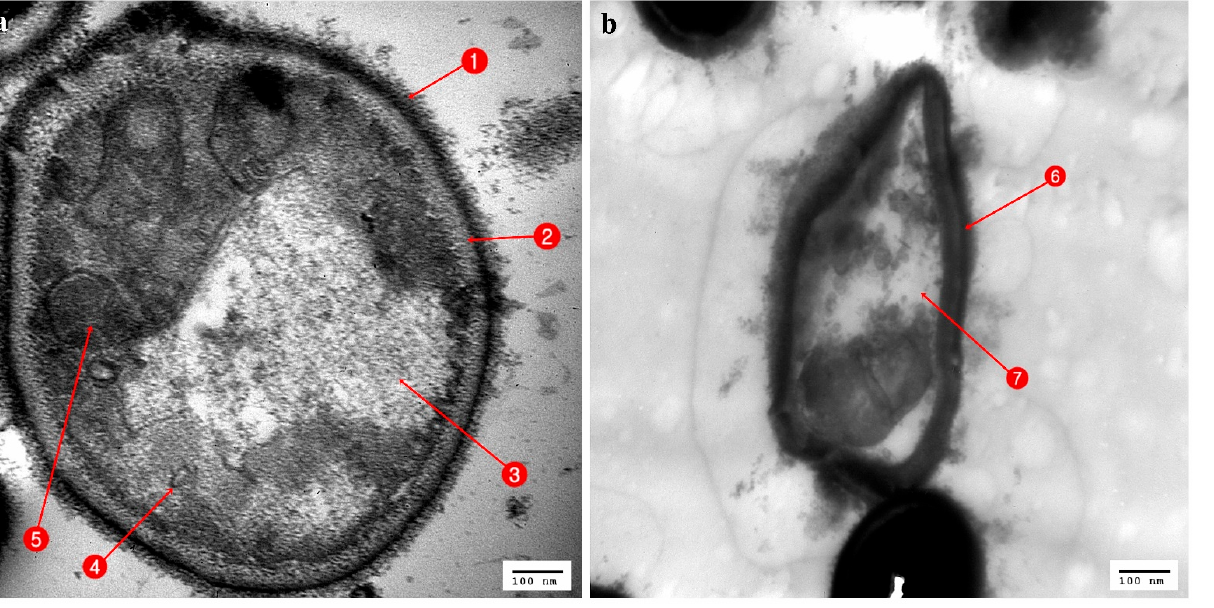
Figure 7. TEM micrograph of Candida albicans ( a ) Normal cells: 1. Cell wall; 2. Cell membrane; 3. Vacuole; 4. Mitochondria; 5. Nucleus; ( b ) cell affected with Bacillus cereus ; 6. Irregular cell wall; 7. Nonhomogeneous cytoplasm.